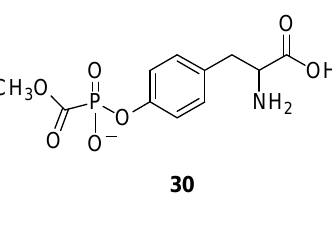
Figure 11. Chemical structure of the phosphonoformate- L -tyrosine conjugate.